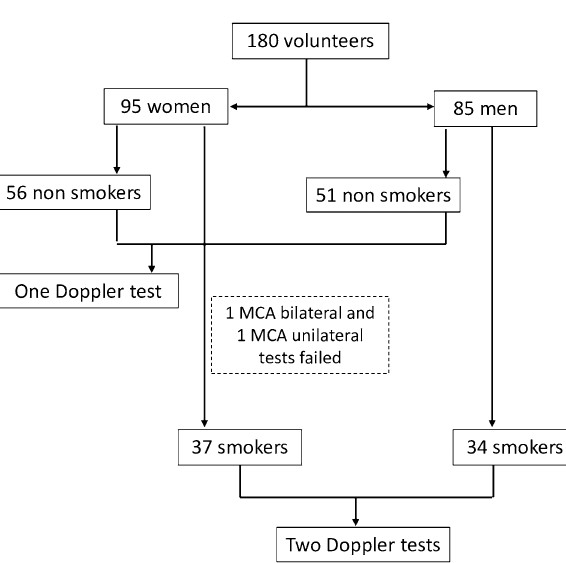
Figure 1. Flowchart showing the inclusion of smokers and controls in this